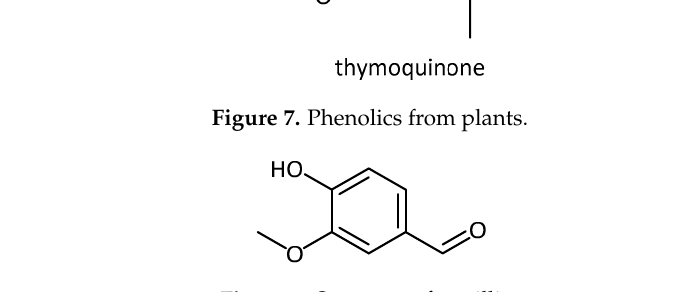
Figure 8. Structure of vanillin.